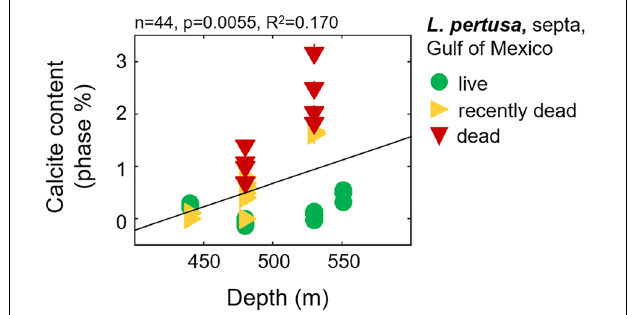
FIGURE 5 | Calcite contents in Gulf of Mexico L. pertusa septa samples as a function of increasing water column depth, with corals collected at various states– live, recently dead, and dead.